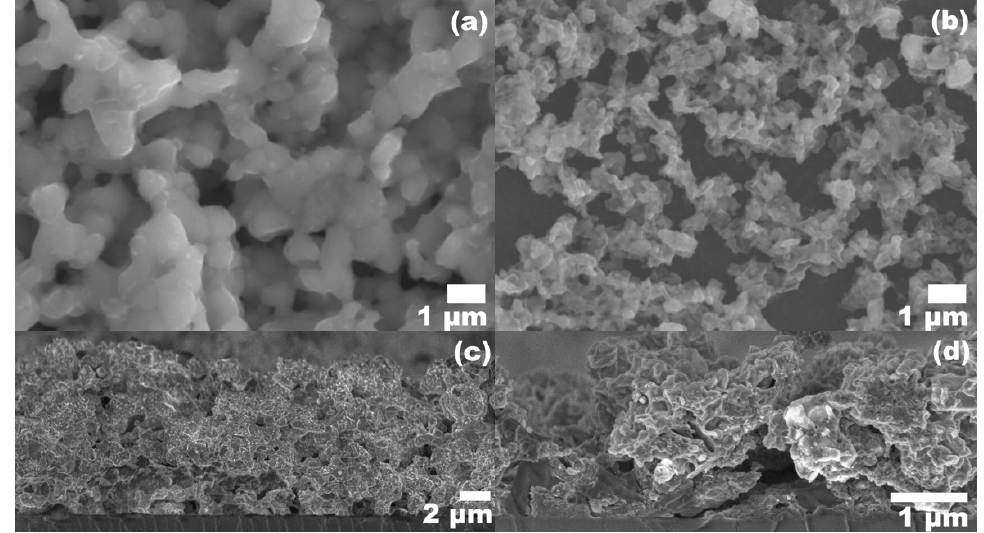
Figure 7. Microstructure of CZTS thin films obtained at di ff erent solid concentration at 1:9 dilution of (NH 4 ) 2 S:H2O. ( a , c ) 550 mg / mL planar and cross-sectional view, ( b , d ) 100 mg / mL planar and cross-sectional view,